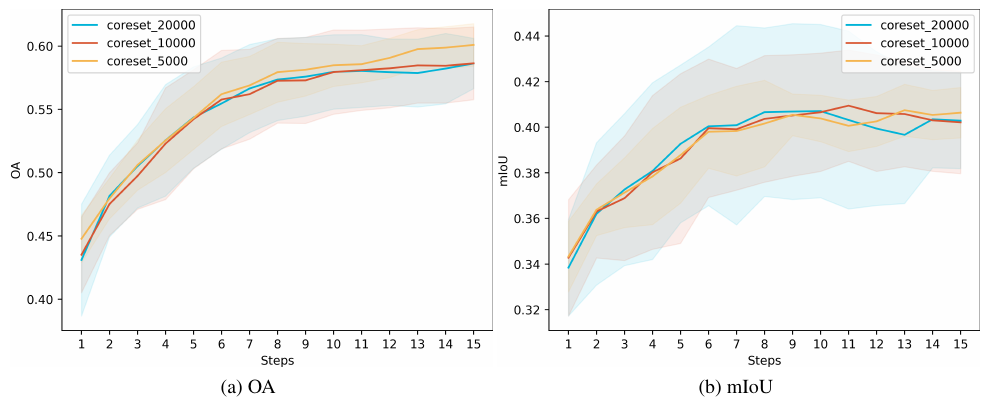
Figure 2. Accuracy metrics over the Coreset process. coreset corresponds to the run without the data preprocessing. coreset 20000 , coreset 10000 and coreset 5000 correspond respectively to the runs with a 20000, 10000 and 5000-regions preprocessing.